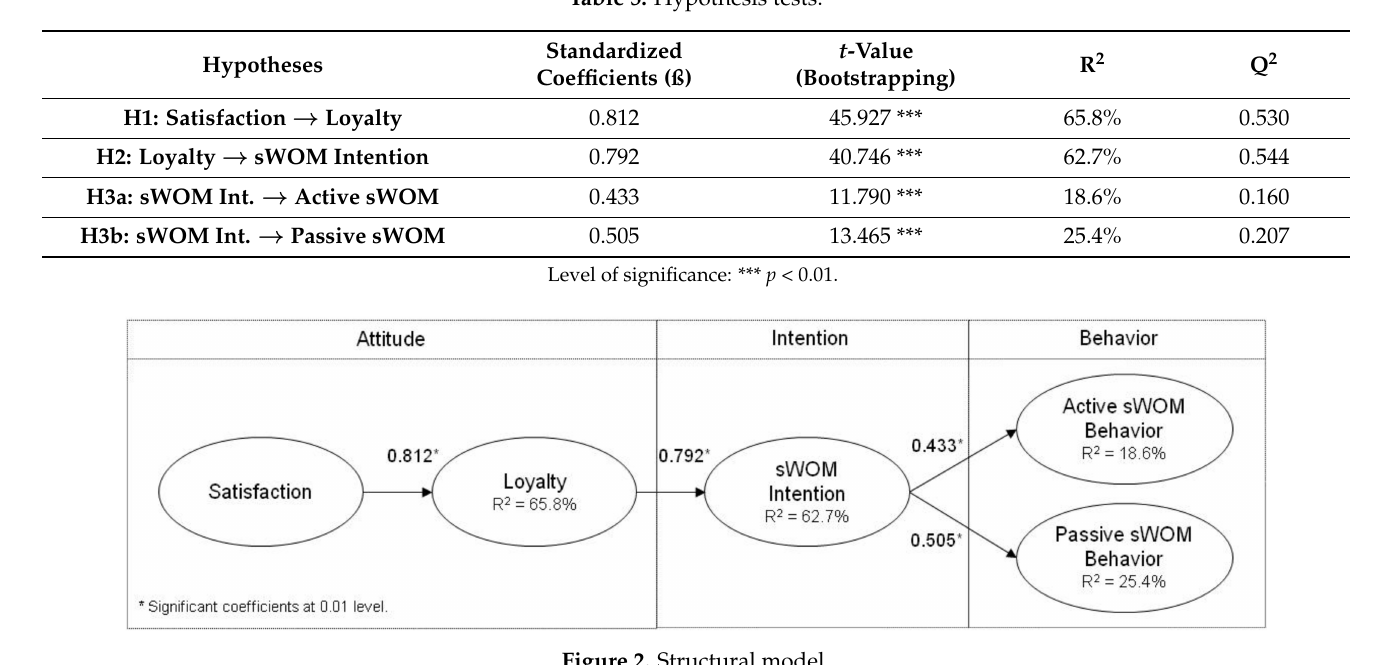
Table 5. Hypothesis tests.